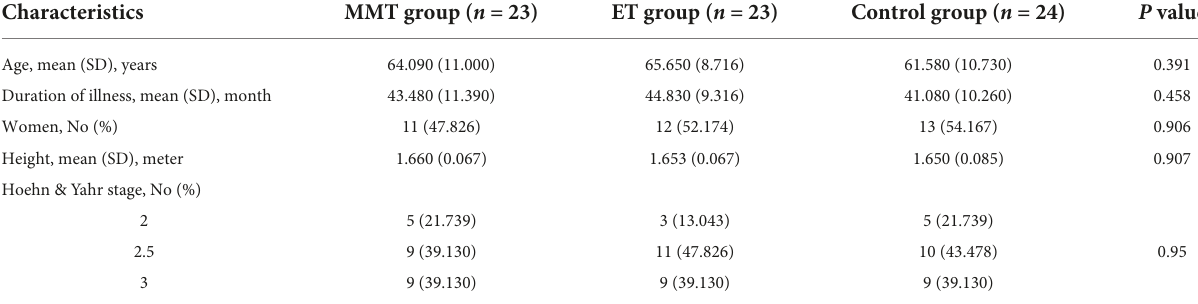
TABLE 1 Baseline characteristics.